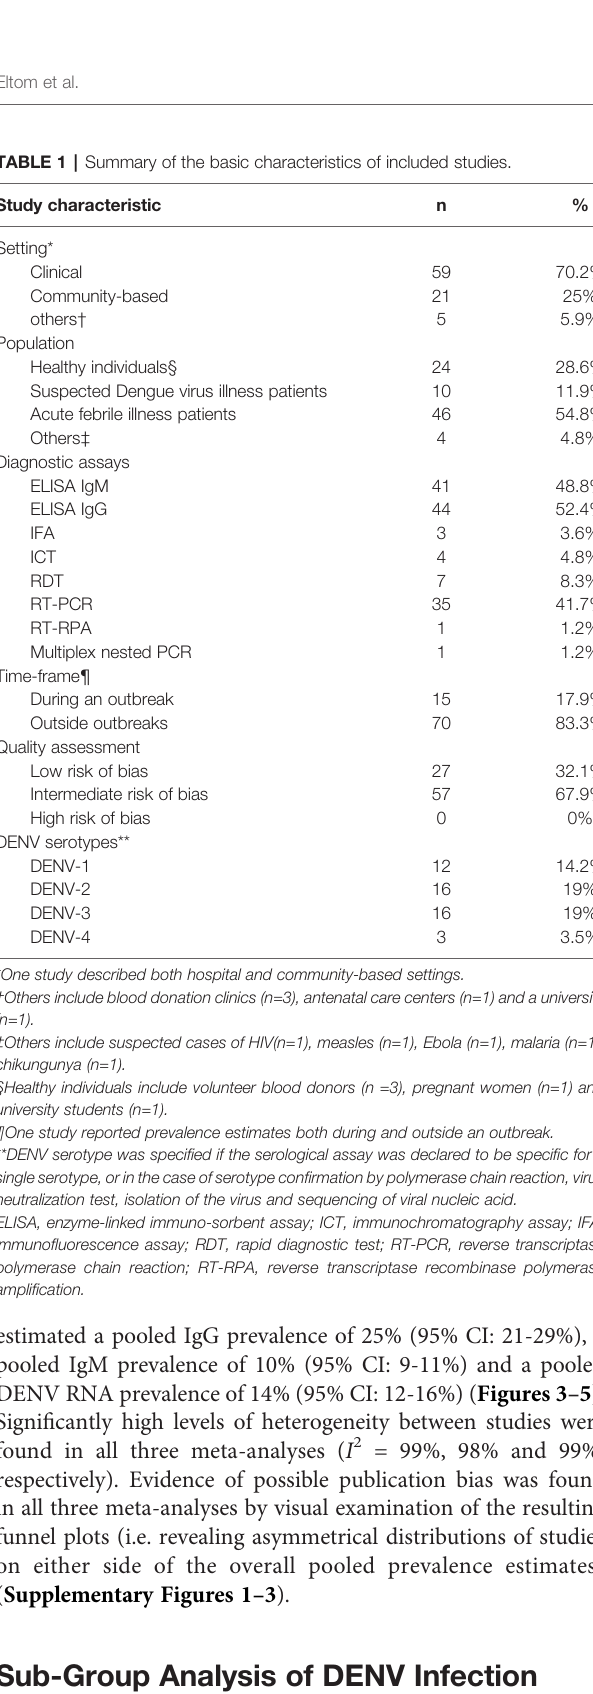
TABLE 1 | Summary of the basic characteristics of included studies.